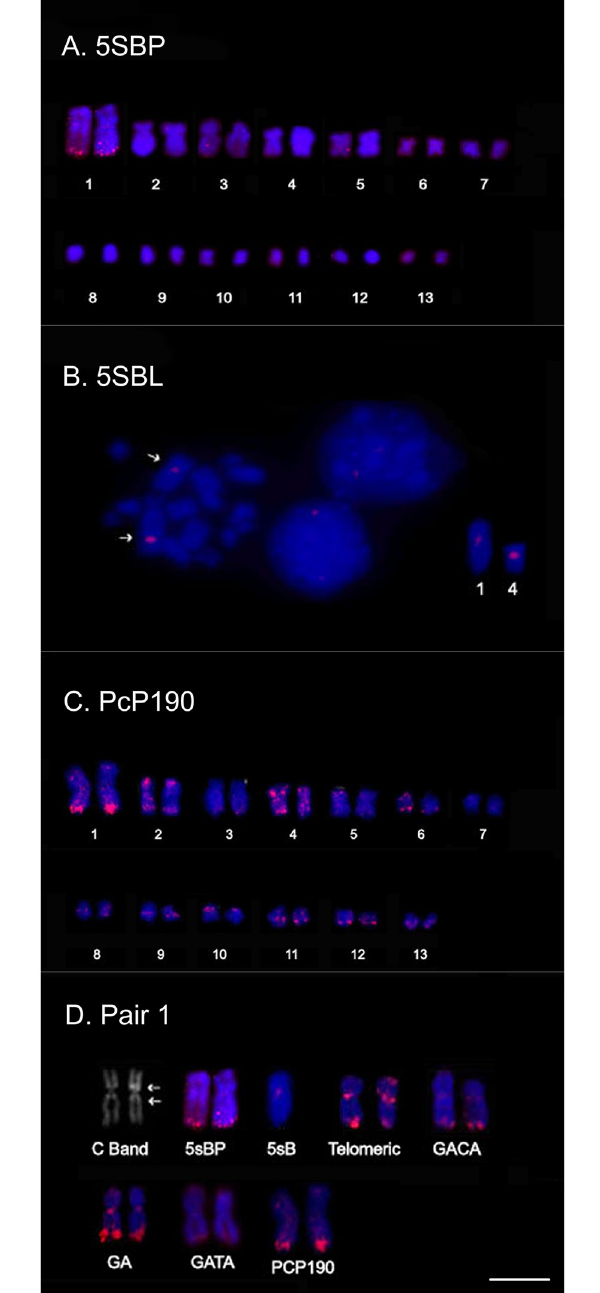
Fig 4. Chromosomal mapping. A. Location of CB5STII.b in the long arms of pair 1. B. Hybridization signal of CB5STIIa. C. Mapping of PcP 190 SatDNA. D. Comparative hybridization signals in chromosome pair 1 of Cycloramphus bolitoglossus . Bar: 5 μ